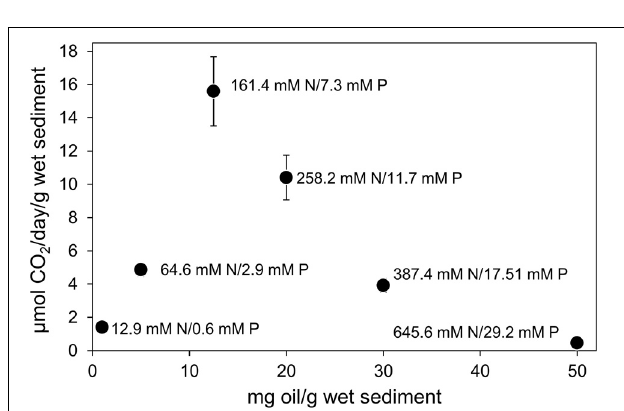
FIGURE 4 | Effect of oil concentration on the rate of CO 2 production in microcosm comprising 10g beach sediment and 10–500mg North Sea crude oil amended with a constant ratio of 5% N and 0.5% P w/w of oil. Sodium nitrate and potassium dihydrogen phosphate were used as N and P sources. Each point is annotated with the concentration of N and P in millimolar terms, based on the water content of the sediments. Each data point represents the average value of three replicates. Where error bars are not seen they are smaller than the symbols.